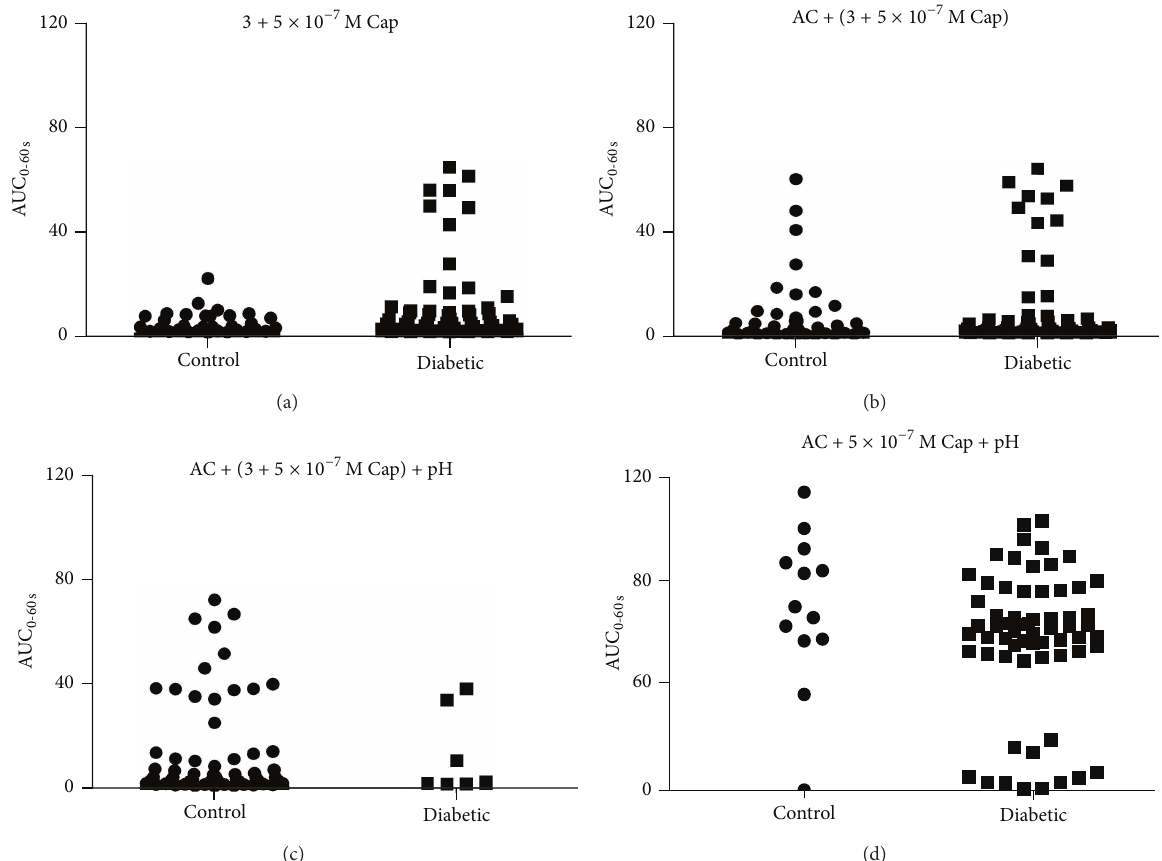
Figure 5: Scatter plots displaying AUC for neurons from control and diabetic animals derived from stimulation with (a) capsaicin, (b) combination of Capsaicin and algogenic chemicals (AC); (c) combination of 0.3 𝜇 M Capsaicin and AC at pH 6.0, and (d) 0.5 𝜇 M Capsaicin and AC at pH